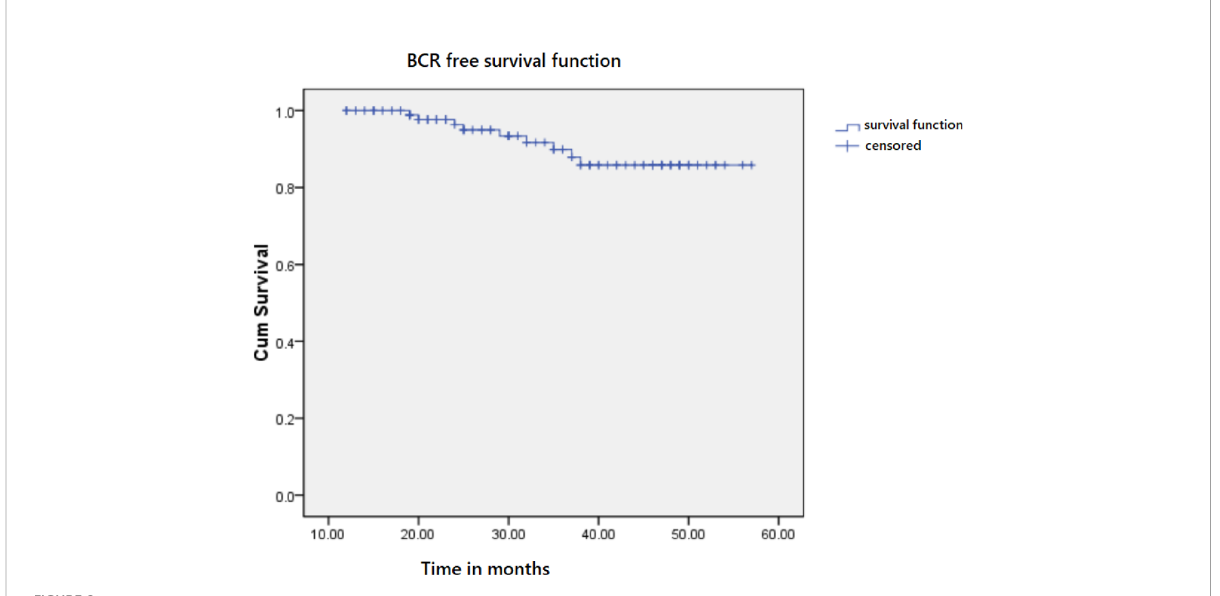
FIGURE 2 Kaplan – Meier curve for overall BCR-free survival